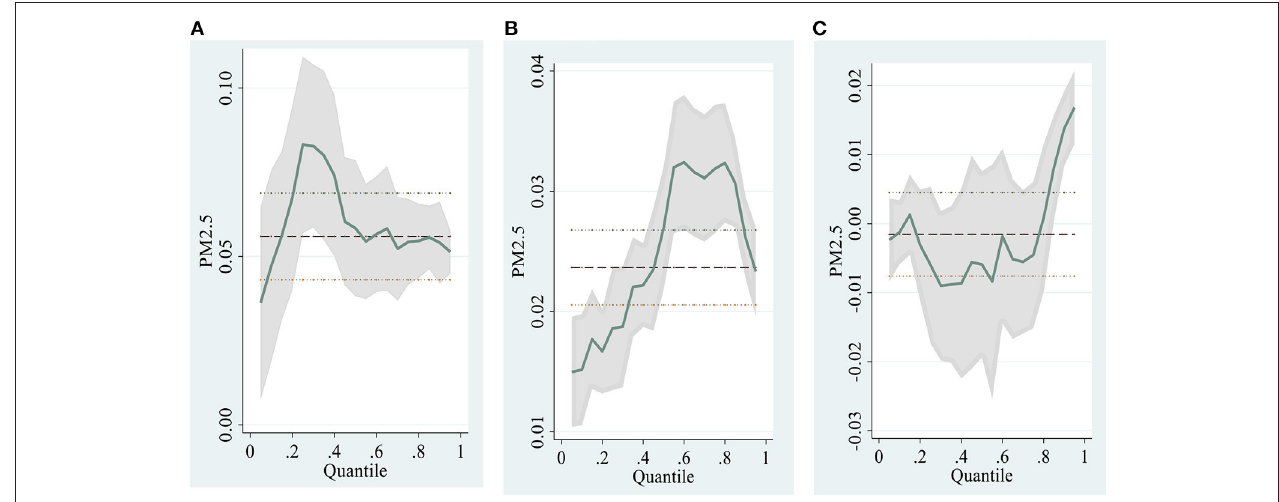
FIGURE 4 | Charts for quantile regression results. (A) Store-level (B) Product-level (C)